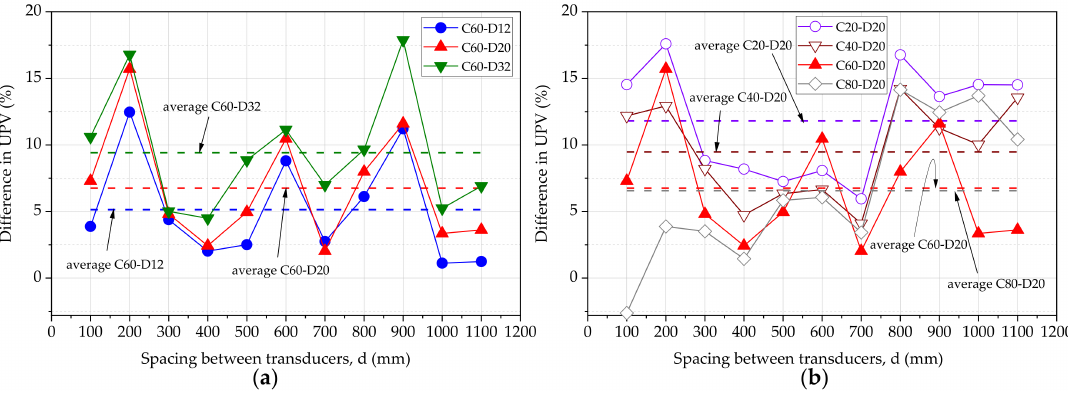
Figure 6. % change in UPV ( a ) varying bar diameter ( b ) varying cover